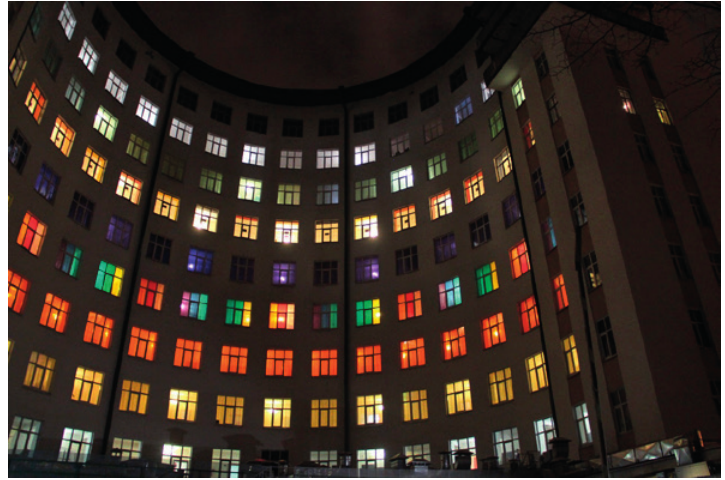
Figure 2. The art-work Zheng Yunhan “Whisper of Light” on the courtyard facade of the Iset Hotel. Photo by Liudmila Starostova,